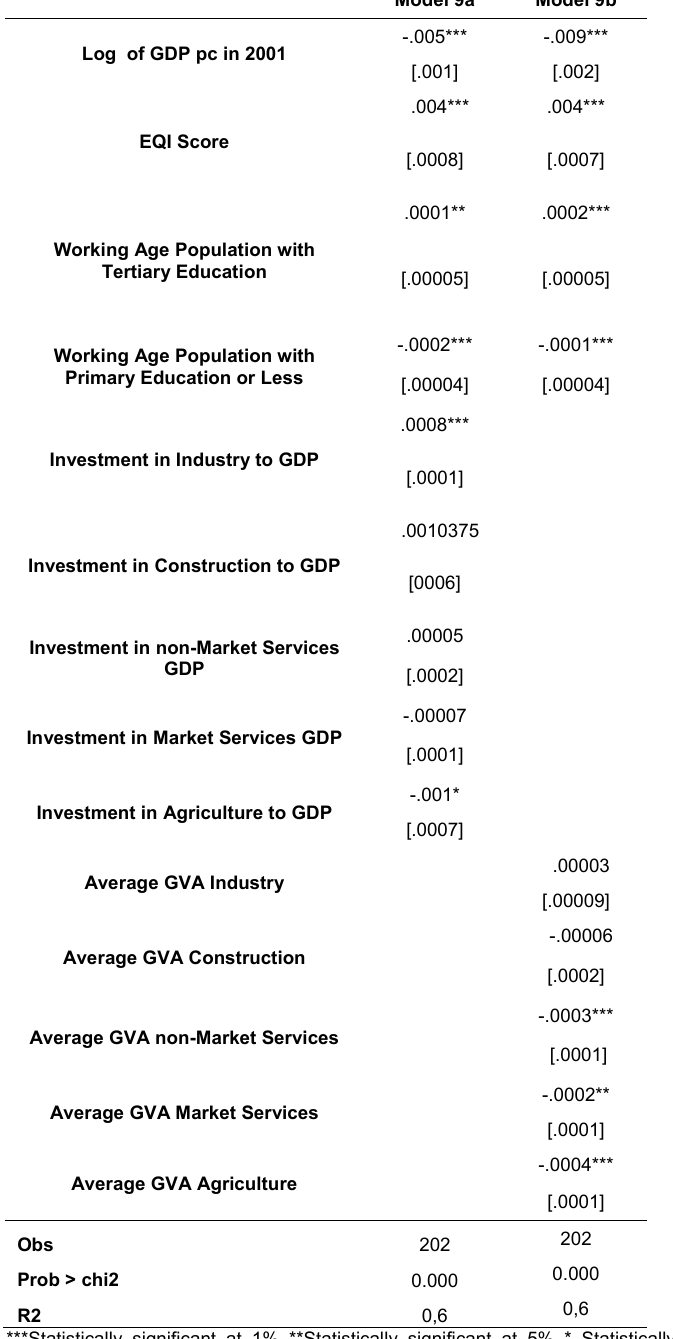
Table 12 . OLS version of the original probit models. Dependent variable: average GDP per capita growth